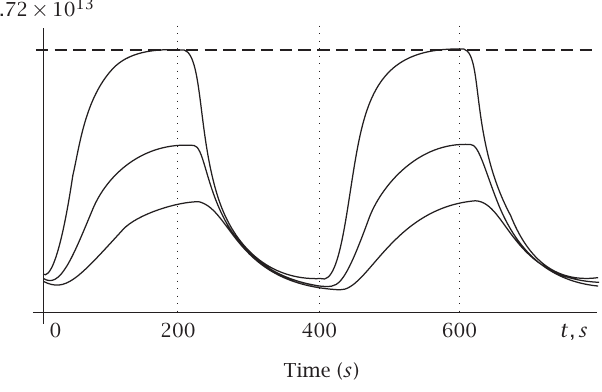
Figure 2.1 . Influence of diffusion coefficient on outlet flux.